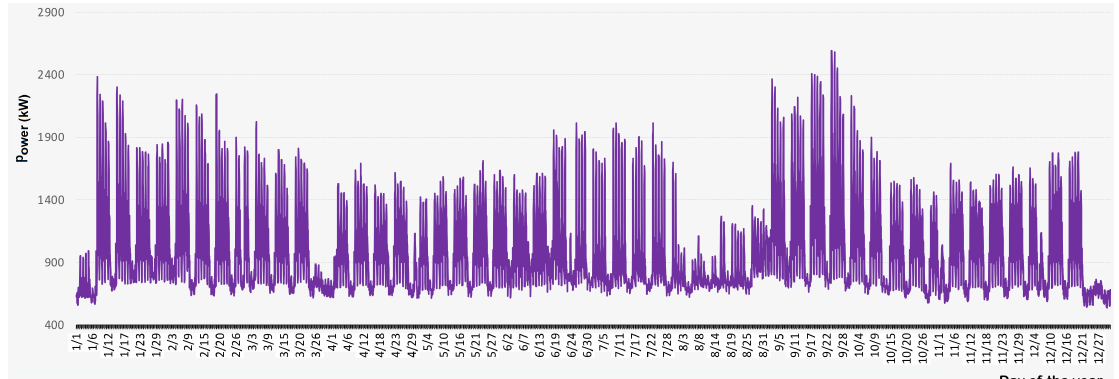
Figure 6. Annual load curve of the university analyzed (year